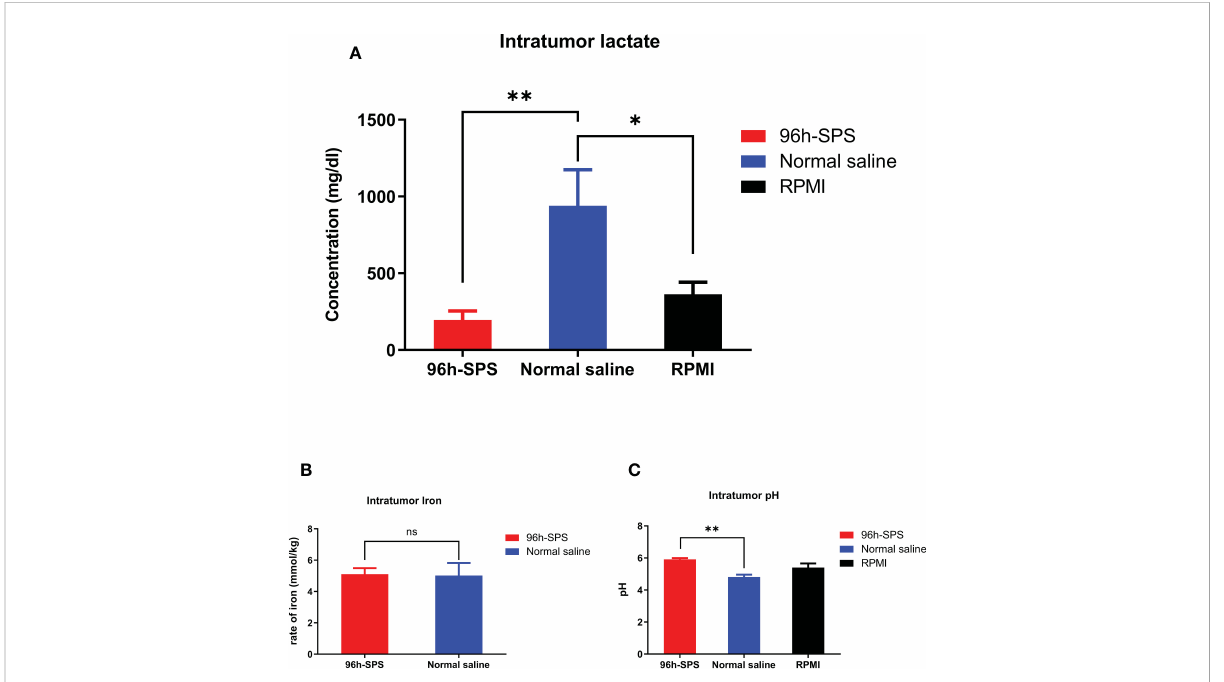
FIGURE 6 Evaluation of intra-tumor lactate, iron, and pH levels in rats tumorized with LA7. (A) The lactate level in different groups. The 96 h-SPS – treated cells exhibited the lowest levels of lactate (B) The level of intra-tumor iron in different treated groups. There was no signi fi cant difference between 96 h-SPS and normal saline in the viewpoint of iron concentration (C) The H + ions level in all treated groups. The 96 h-SPS – treated cells exhibited the highest levels of intra-tumor pH value. Data are expressed as mean ± SD; bars indicate the SD. In each panel. ns = non- signi fi cant, * p < 0.05, and ** p <